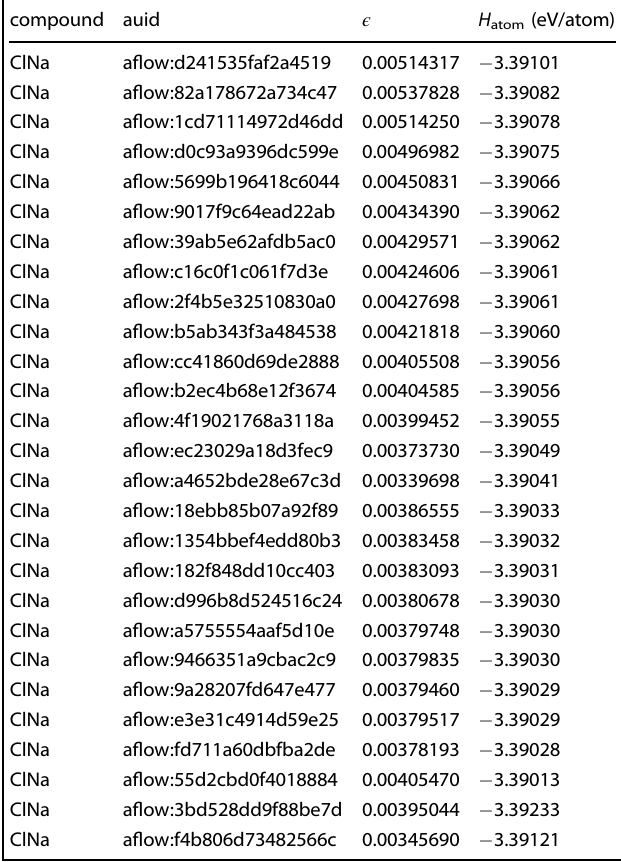
Table 1. AFLOW.org entries equivalent to an input sodium chloride (rocksalt) compound. A list of equivalent compounds to the Prototype Encyclopedia ’ s rocksalt structure with the default degrees of freedom (label = AB_cF8_225_a_b, parameters = 5.64 Å ). The compound name, auid, mis fi t ( ϵ ), and enthalpy per atom ( H atom ) are listed for all similar structures in the database. Volume scaling is suppressed for the comparison to incorporate volume differences. The fi rst 25 and last 2 entries are from AFLOW ’ s ICSD and LIB2 catalogs,